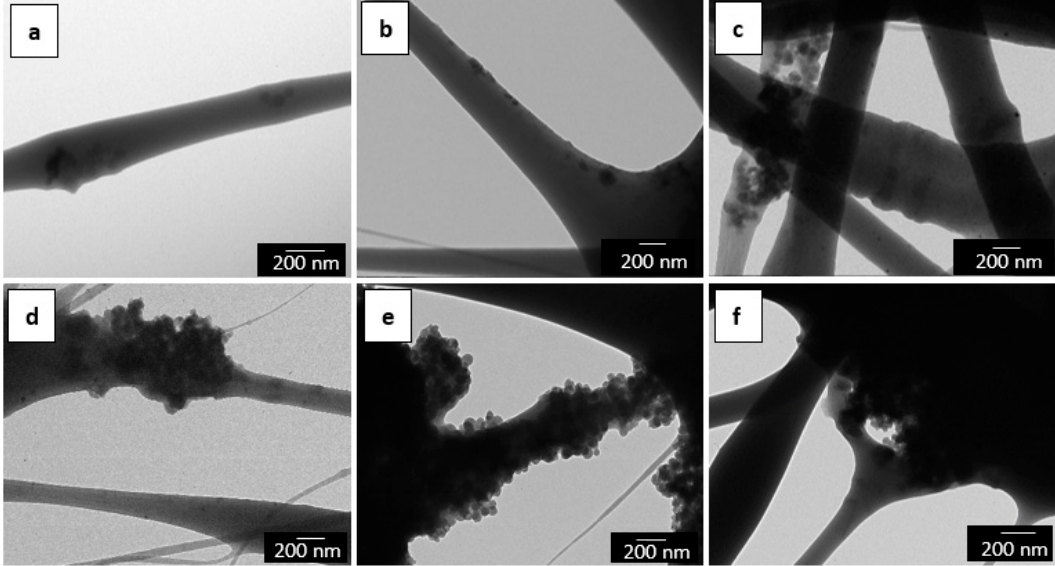
Figure 3. Transmission electron microscopy (TEM) images of the electrospun fibers of poly(3-hydroxybutyrate- co -3-hydroxyvalerate) (PHBV)/Mobil Composition of Matter (MCM)-41 with eugenol: ( a ) 2.5 wt.-% MCM-41 + eugenol; ( b ) 5 wt.-% MCM-41 + eugenol; ( c ) 7.5 wt.-% MCM-41 + eugenol; ( d ) 10 wt.-% MCM-41 + eugenol; ( e ) 15 wt.-% MCM-41 + eugenol; ( f ) 20 wt.-% MCM-41 + eugenol. Scale markers of 200 nm.